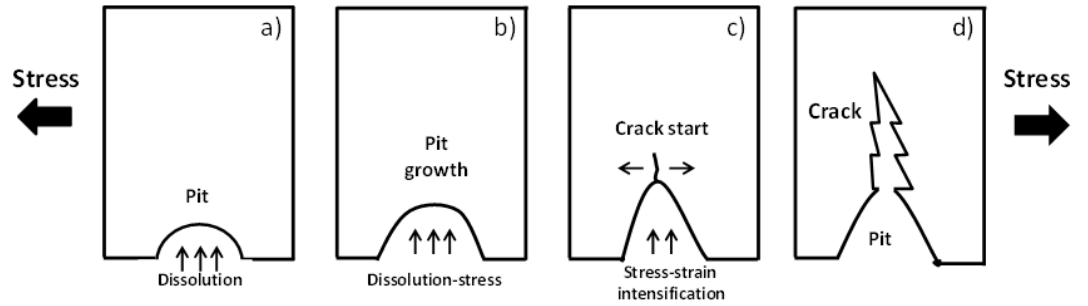
Figure 3. Schematic representation of the pit to crack transition [59]. ( a ) pit initiation, ( b ) pit growth, ( c ) crack start, and ( d ) final crack.